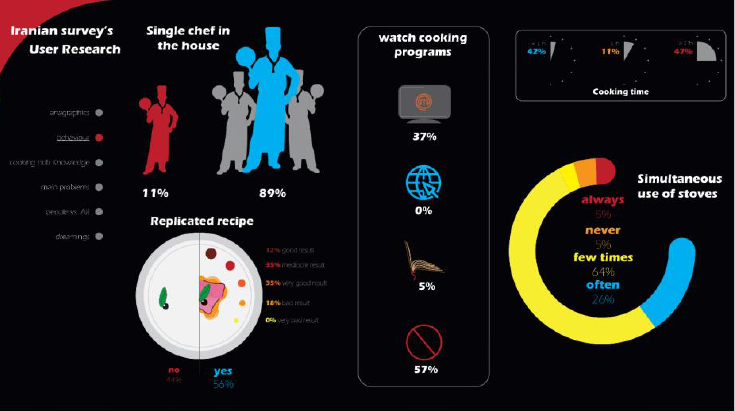
Figure 3. User research preliminary study example. Students research their users, targeting